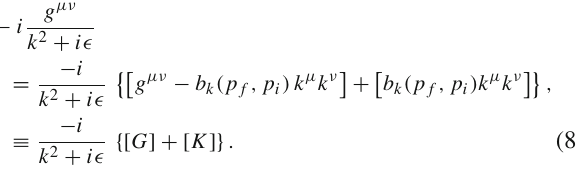
the photon flowing in at the vertex V , and the remaining n photon momenta can be arbitrarily soft), and examining the effect of adding an additional virtual or real ( n + 1 ) th pho- ton with momentum k to this graph in all possible ways. All insertions on the graph to the right 7 of the vertex V are clas- sified as insertions on the (final) p (cid:6) leg; see Fig. 4, whereas those to the left of the vertex V are deemed to be insertions on the (initial) p leg. Hence there are three possibilities for virtual photon insertions, viz., both vertices of the ( n + 1 ) th virtual photon being inserted on the p (cid:6) leg, both inserted on the p leg, and finally, one vertex inserted on each